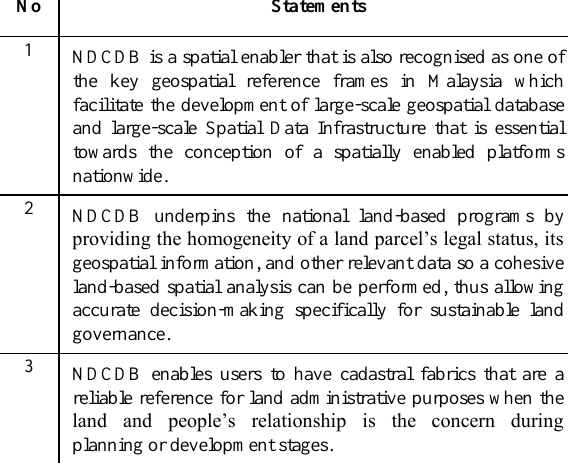
Table 3. Round 2 statements on NDCDB‘s significant role in land- based